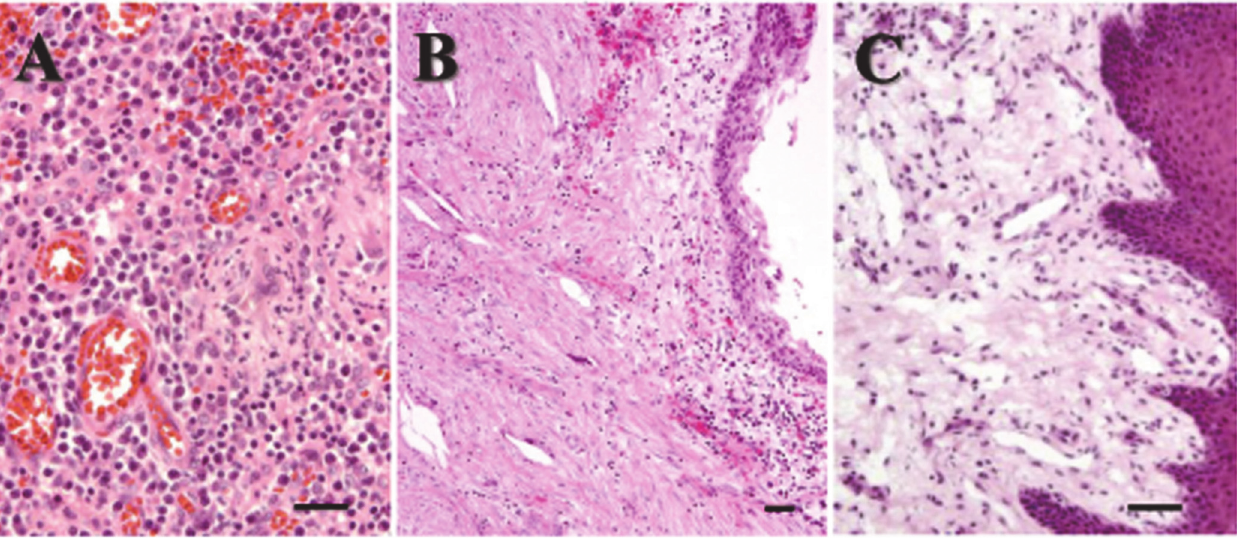
Fig 2. Histological evaluations of the specimens. Paraffin sections (n = 40) were stained using hematoxylin and eosin. Scale bar = 100 μ m. (A) Periapical granulomas (n = 32) showing a large number of inflammatory cells and microvessels. (B) Radicular cyst (n = 8) showing epithelial cell layer and cholesterol clefts. (C) Healthy gingival tissues (n = 10) showing epithelial cell layer and lower cell number of infiltrating cells in comparison with periapical granulomas.